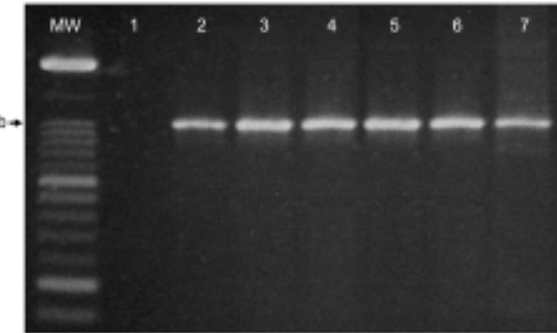
Fig. 2. Agarose gel (1.4%) electrophoresis of RT-PCR products of 2’-5’A synthetase mRNA (clone E18) isolat- ed from transgenic tobacco plants: MW, molecular weight marker; 1, nontransformed control; 2–6, transgenic plants; 7, positive control (pBI121-